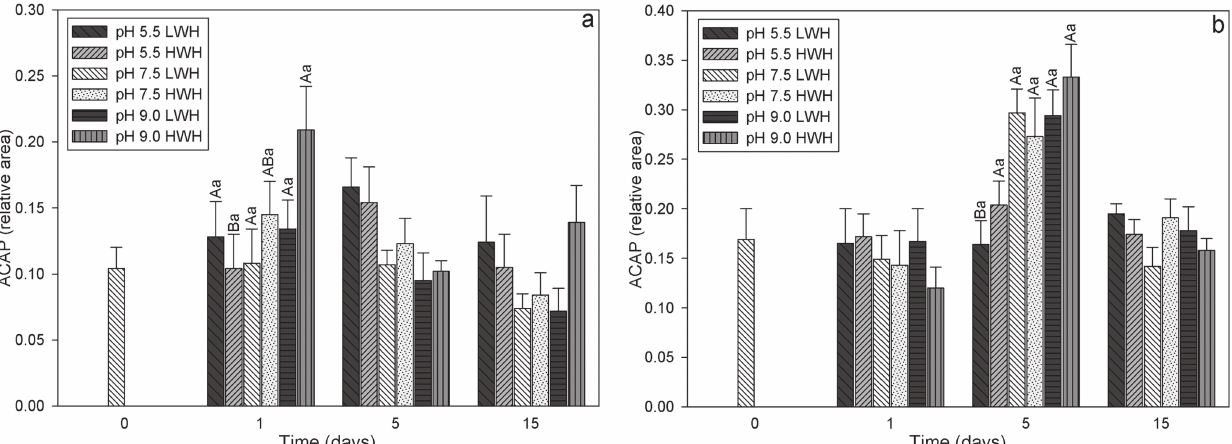
Fig. 2. Total antioxidant capacity against peroxyl radicals (ACAP) (relative area) in a. gills and b. kidney of pacu ( Piaractus mesopotamicus ) juveniles under different water hardness and pH at different times. LWH = low water hardness (50 mg L -1 ); HWH = high water hardness (120 mg CaCO L -1 ). Data are presented as the means ± SEM (n = 9 fish treatment –1 ). CaCO 3 3 Different uppercase letters indicate statistically differences between pH at the same hardness (P < 0.05).